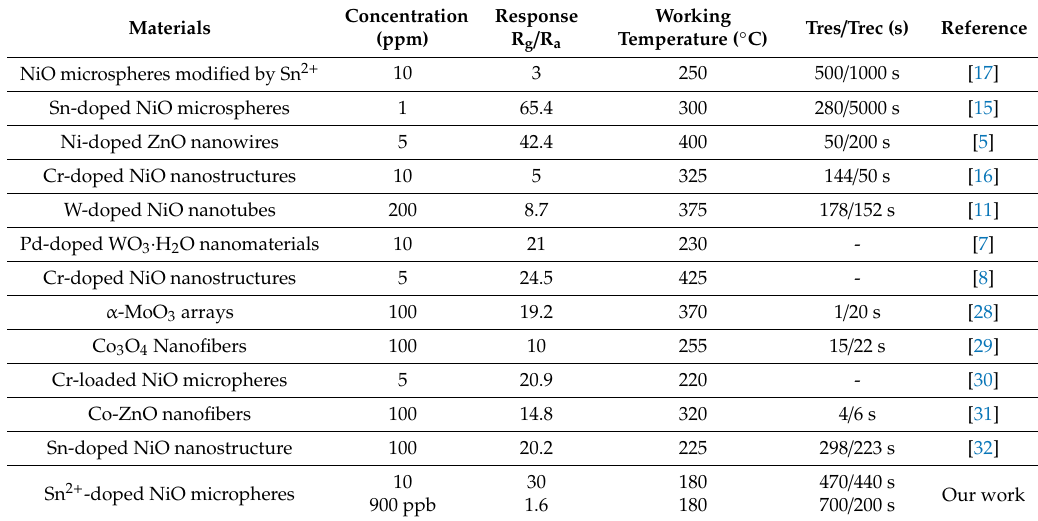
Figure 8. ( a ) Responses of the NiO and SNM-8 sensors as a function of the xylene concentration at 180 ° C; ( b ) Dynamic response of the SNM-8 sensor to 0.9-50 ppm xylene at 180 ° C; ( c ) Response and recovery times of the SNM-8 sensor to 10 ppm xylene at 180 °C; ( d , e ) Response curve of the SNM-8 sensor to 900 ppb and 2 ppm xylene at 180 ° C, respectively; ( f ) Gas responses of the SNM-8 sensor to 10 ppm of various VOCs (X, xylene; T, toluene; A, acetone; F, formaldehyde; E, ethanol), 10 ppm NO 2 , 100 ppm NH 3 , and 100 ppm H 2 at 180 °C.